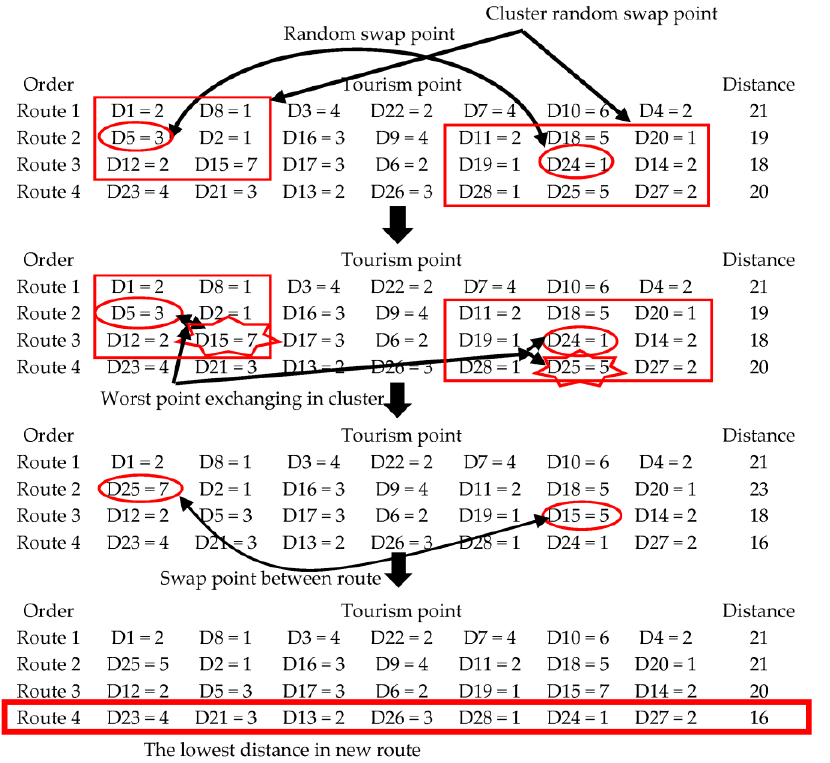
Figure 9. Example of modified node swap insertion.